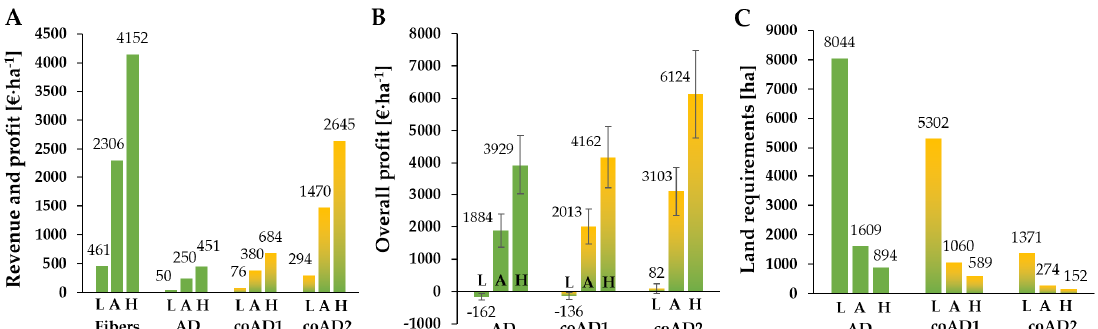
Figure 3. ( A )Potential revenue per hectare from hemp fibers and net profits of biomethane from hemp hurds (HH) with and without cheese whey (CW), ( B ) overall profit per hectare, ( C ) and land required to sustain the production of a 200 Nm 3 · h − 1 biomethane plant. Bars in panel B indicate the range of overall profit obtained by considering a low ( − 20%) and a high ( + 20%) price range for fibers and biomethane. L, A, and H relate to low, average and high hemp biomass productivities of 2, 10 and 18 ton · ha − 1 · y − 1 , respectively. AD: AD of single HH; coAD1: coAD with 30% CW + 70% HH; coAD2: coAD with 70% CW + 30% HH.